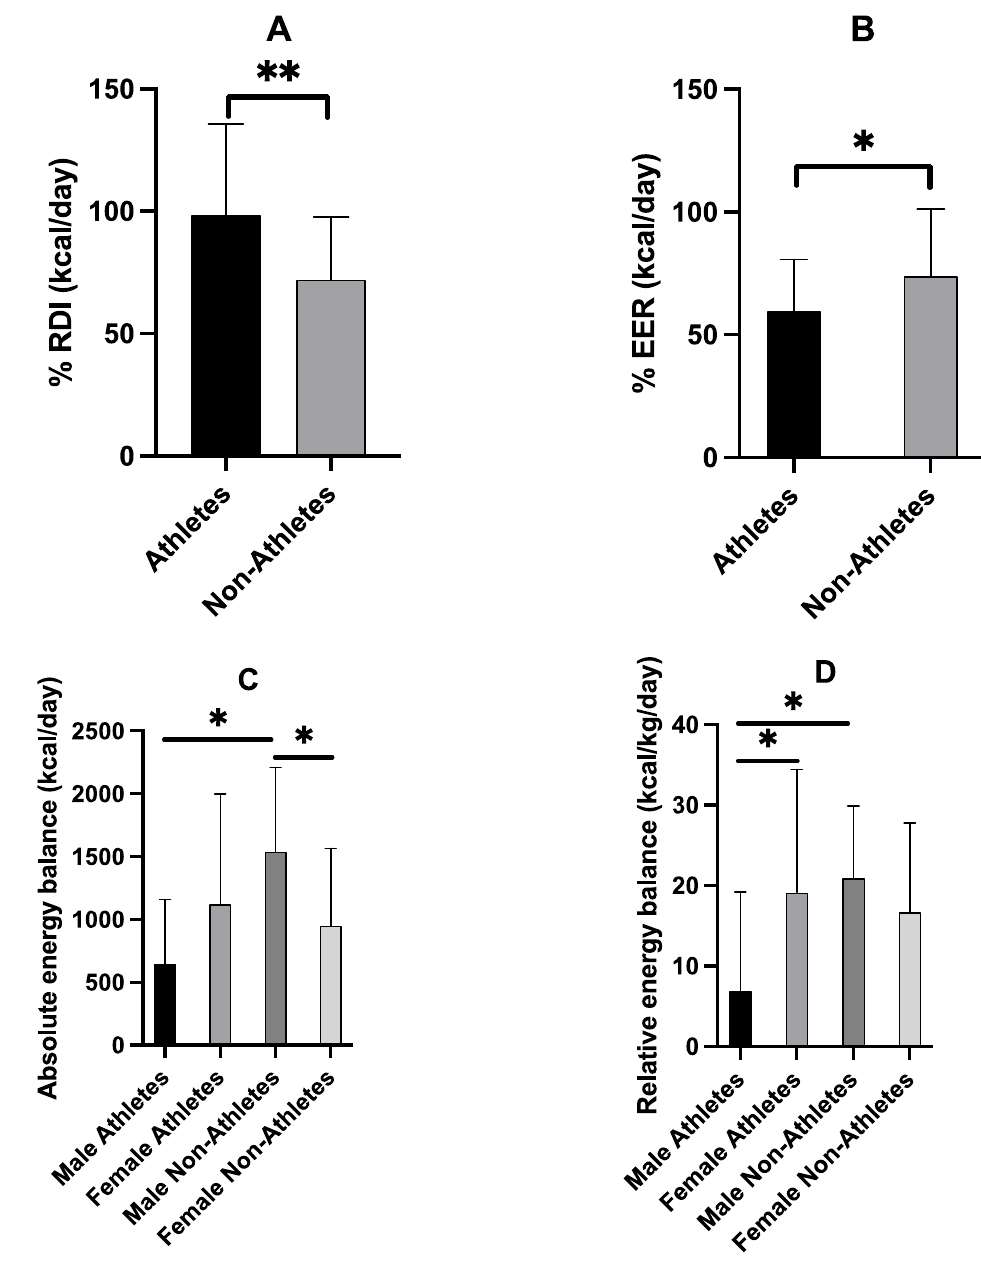
Figure 4. Energy intake as percentage of the Canadian recommended daily intake, i.e., %RDI ( A ) and as percentage of the estimated energy requirements, i.e., %EER ( B ) in athletes ( n = 58) and nonathletes ( n = 58). The RDI for adults and youth (ages 13 and older) is 2000 calories a day. EER uses a formula considering participants age, weight, height, and physical activity score to determine the required intake (kcal/day) relative to the individual. Absolute energy balance was then calculated as the difference between energy intake and energy expenditure expressed in kcal/day ( C ) and relative energy balance was calculated as the difference between energy intake and energy expenditure expressed in kcal/kg/day expenditure ( D ). Values are means ± SD. * denotes p < 0.05 differences between groups; ** denotes p < 0.001 differences between